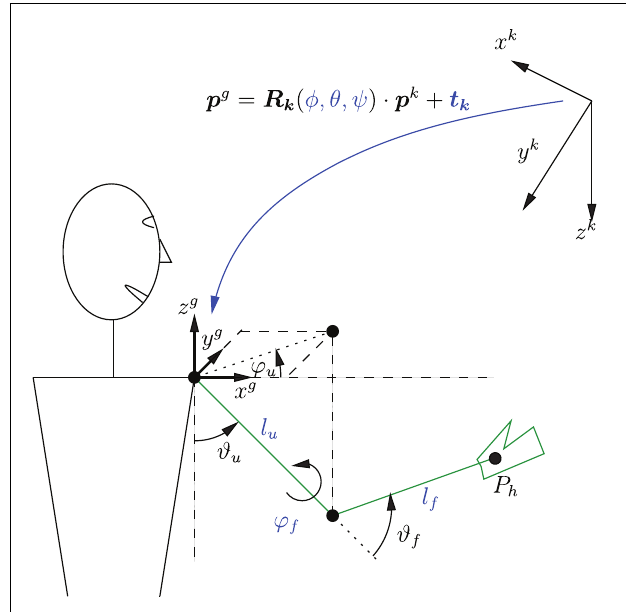
FIGURE 4 | Simplified kinematic model of the exoskeleton with coordinate systems and a transformation between these systems. Depicted is the right arm reaching forward. The parameters of the coordinate transformation φ,θ,ψ, and t k as well as the kinematic model parameters l u , l f , and ϕ f need to be